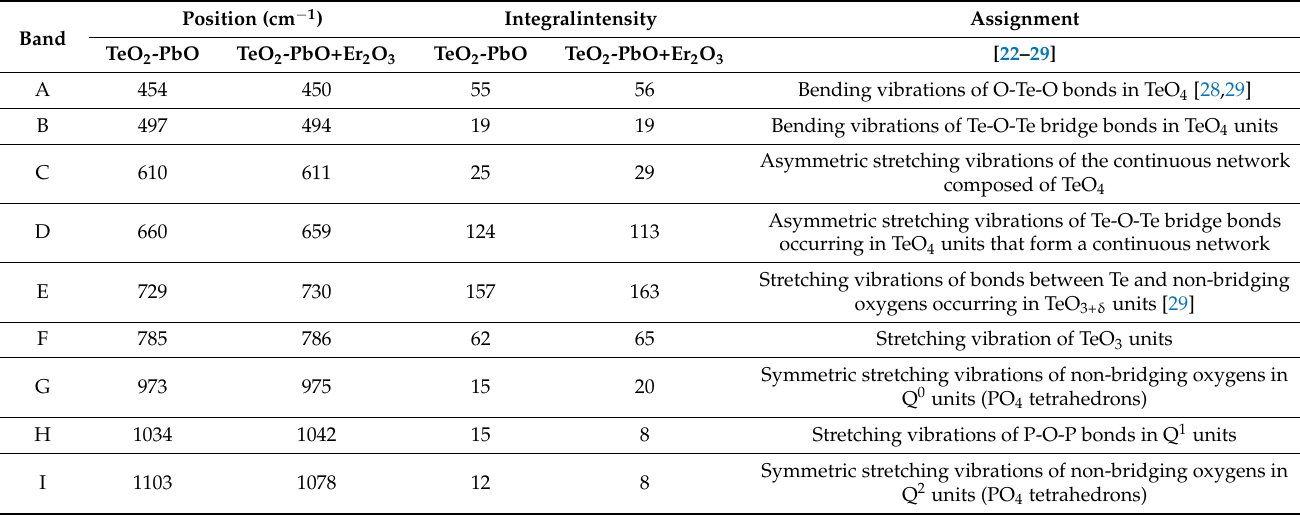
Figure 6. Deconvoluted spectra of S3 and S4 glasses. Table 3. Component band’s parameters of Raman spectra of S1 and S2